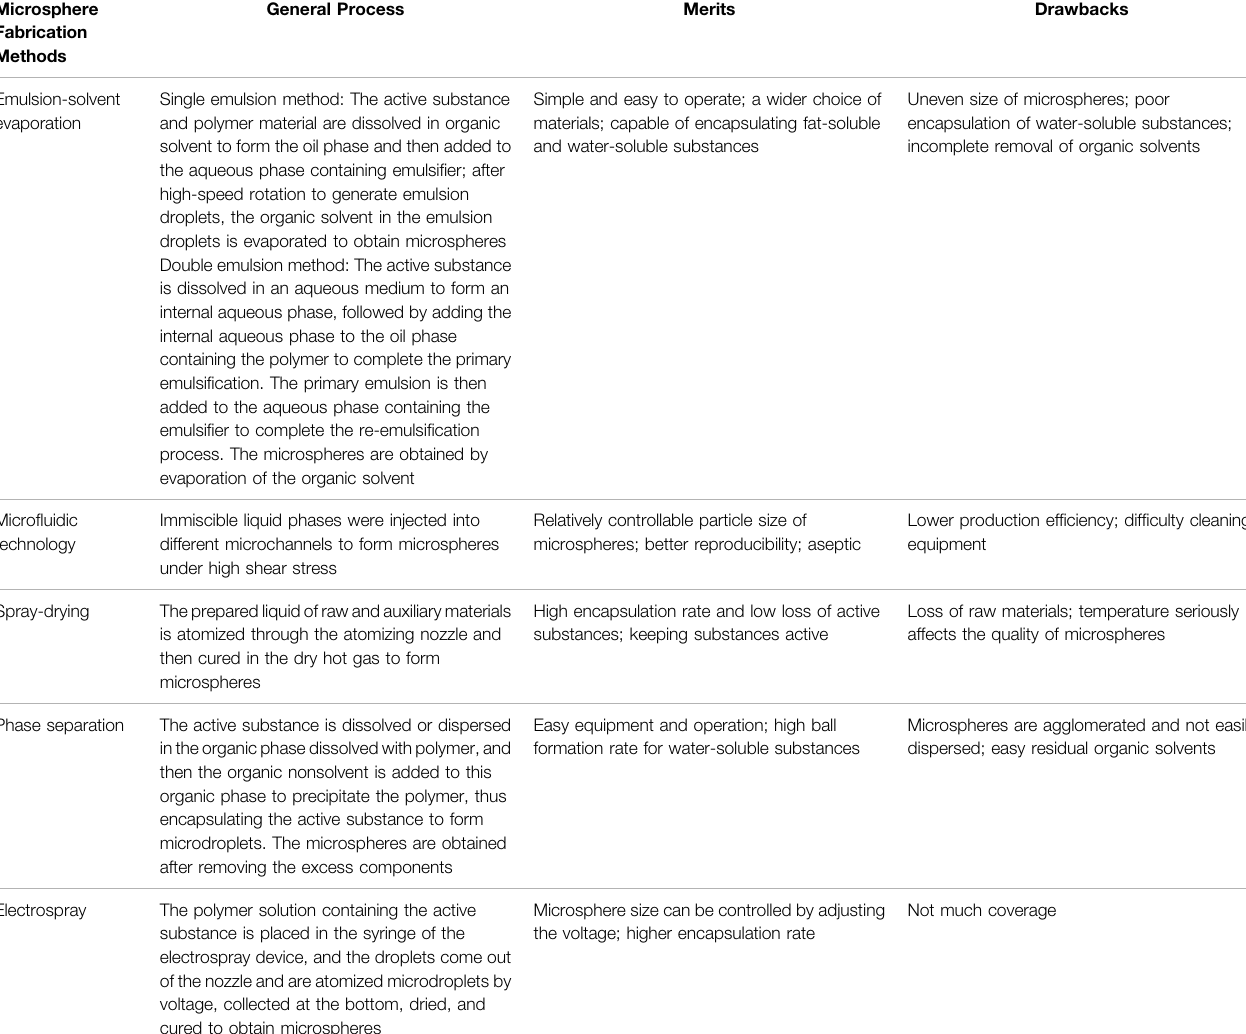
TABLE 1 | Introduction of several common fabrication methods of